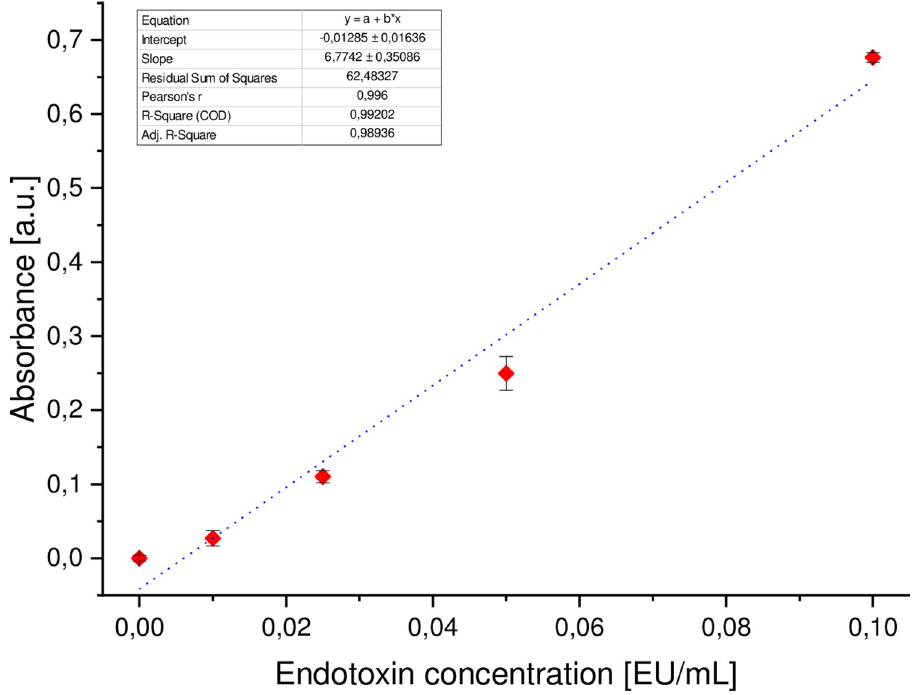
Fig 6. Standard curve (R 2 =